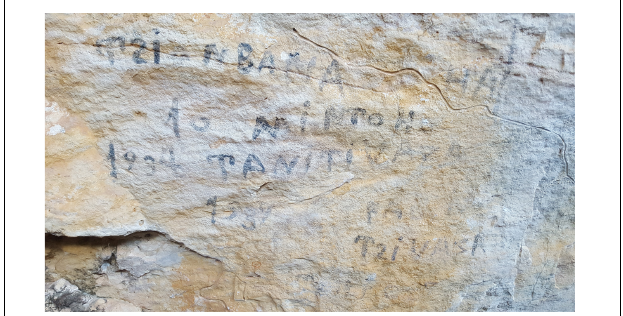
FIGURE 6 | Mahafale graffiti on the western end of the northern wall at Anjohimpaty Rock Shelter.